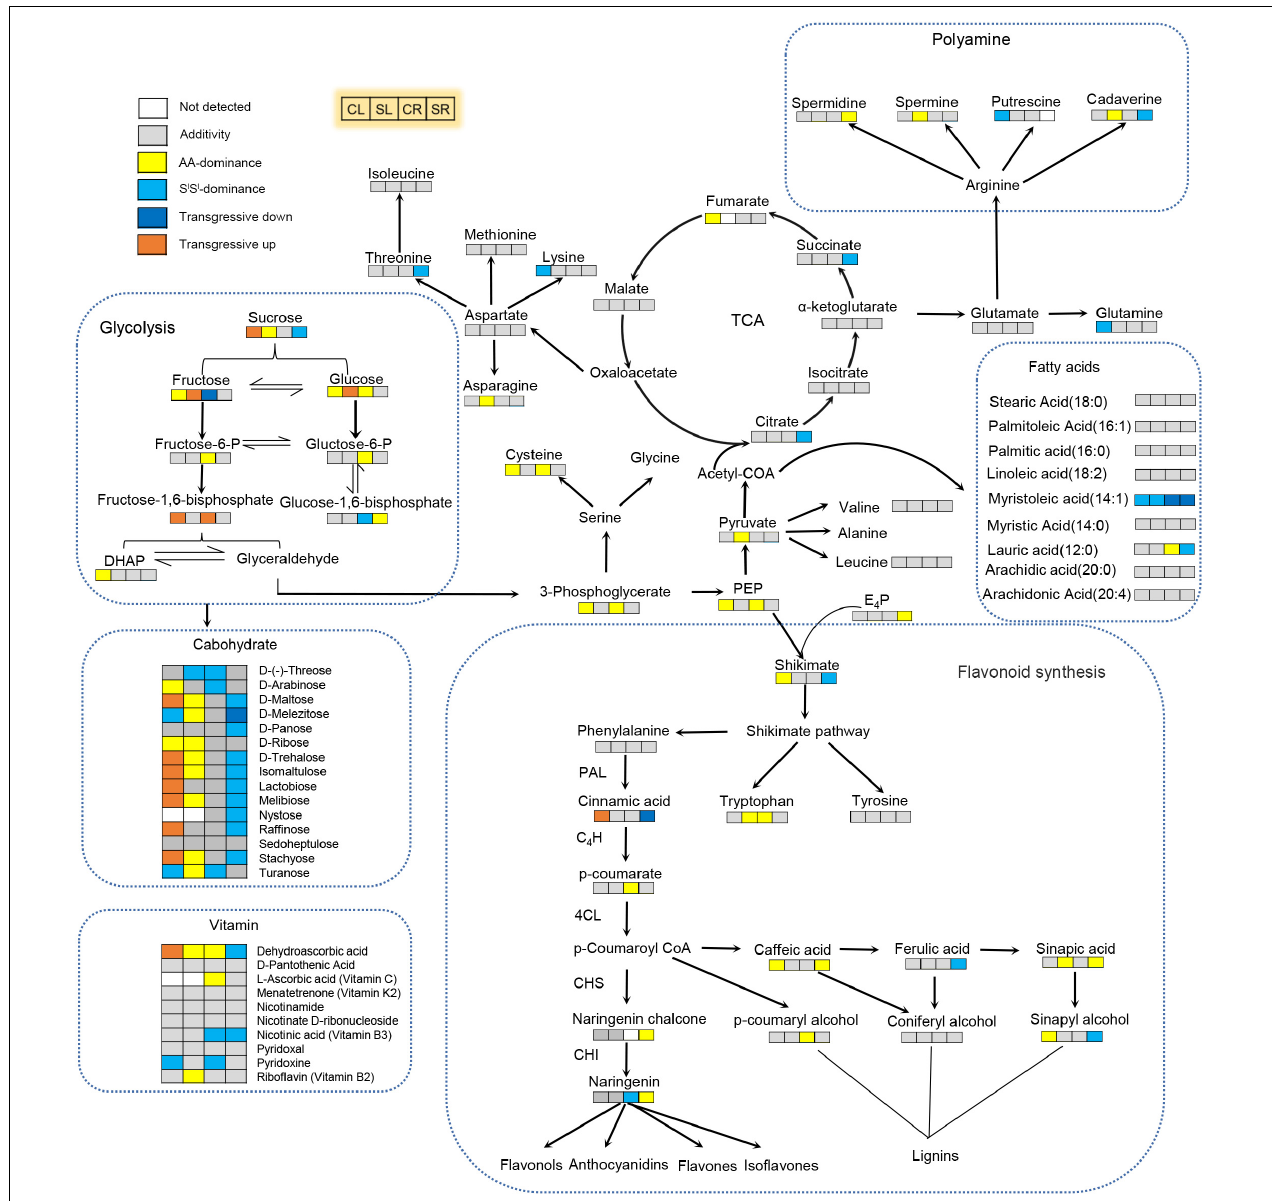
FIGURE 4 | Integrative effects of salinity stress and allotetraploidization on metabolism in a synthetic tetraploid wheat line. Non-additive and additive accumulation of key metabolites in the synthetic tetraploid wheat line were marked on the primary metabolism network. The seedlings were exposed to 150 mM NaCl for 7 days. CL, control leaf; SL, stress leaf; CR, control root; SR, stress root. Joined four rectangle boxes denoted control leaf (CL), stress leaf (SL), control root (CR), and stress root (SR),